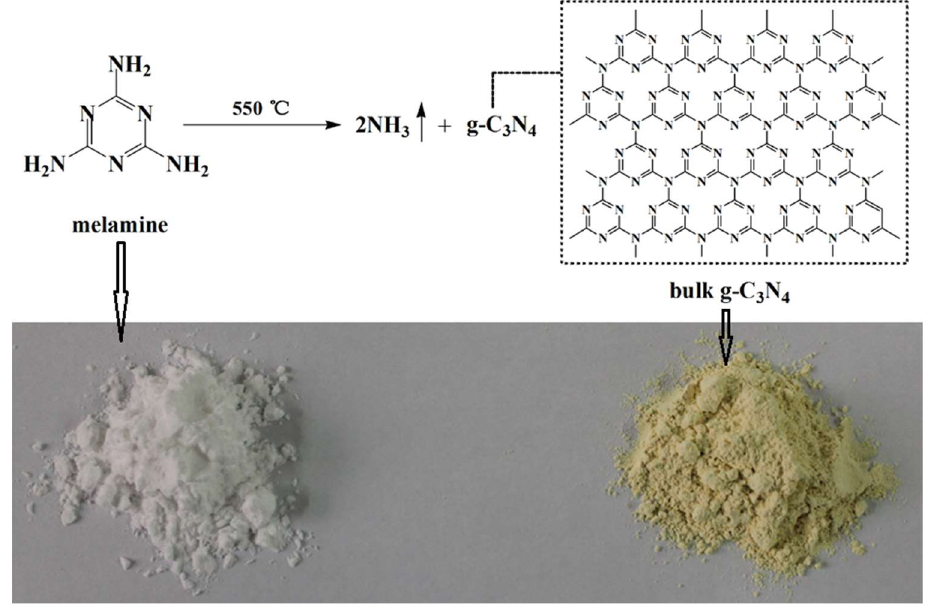
Figure 1. Thermal condensation process from melamine to bulk g-C 3 N 4.